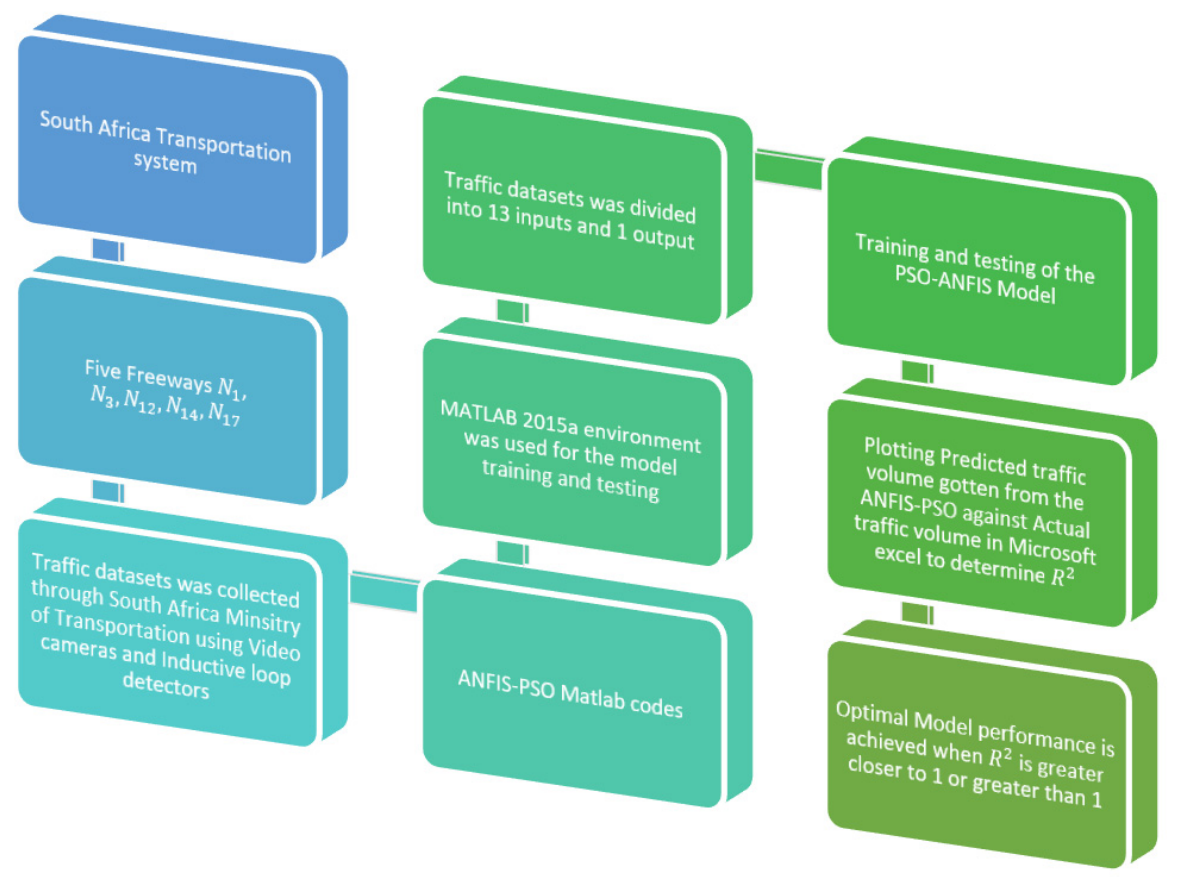
Figure 1. Flowchart of Methodological Approaches used in this Research.